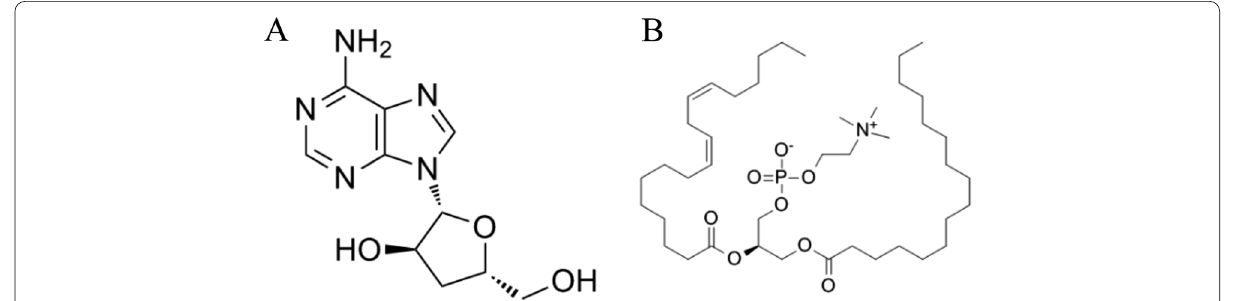
Fig. 1 The chemical structures of cordycepin ( A ) and lecithin ( B